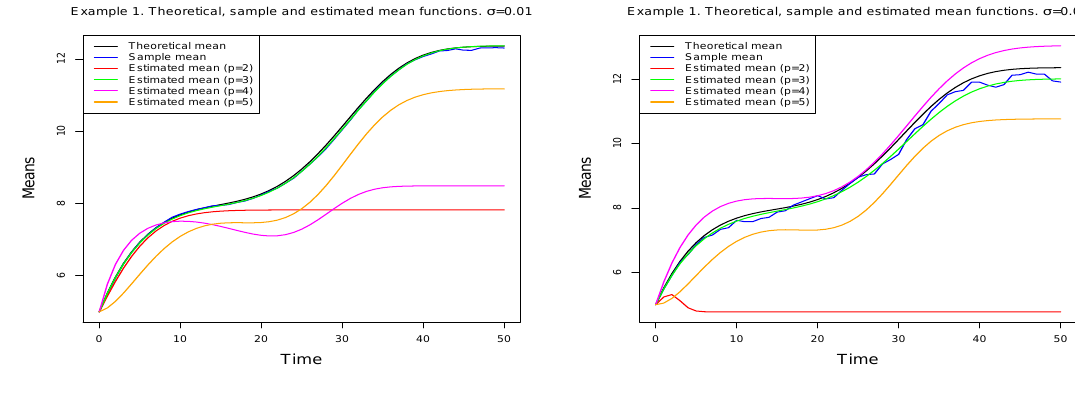
Figure 3. Example 1. Theoretical, sample and estimated mean